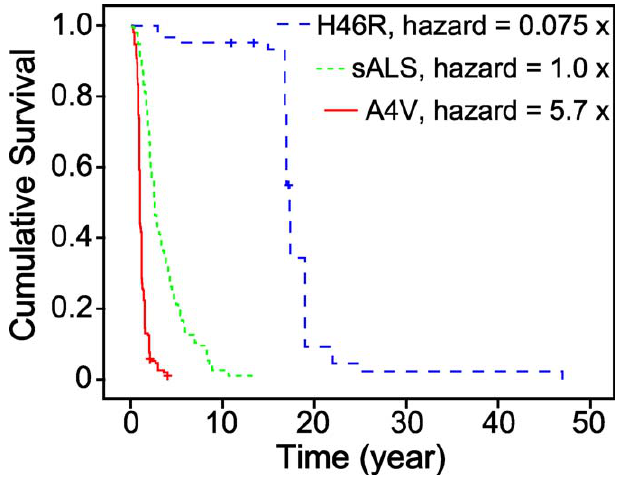
Figure 1. fALS Patients’ Kaplan–Meier Survival Curves Illustrating Low and High Risk SOD1 Mutations Kaplan–Meier survival curves from patients with A4V (red) and H46R (blue) SOD1 mutations and sALS (green) are as shown. Disease durations from 205 patients with A4V SOD1 mutation, 63 patients with H46R SOD1 mutation, and 269 patients with sALS were used to generate